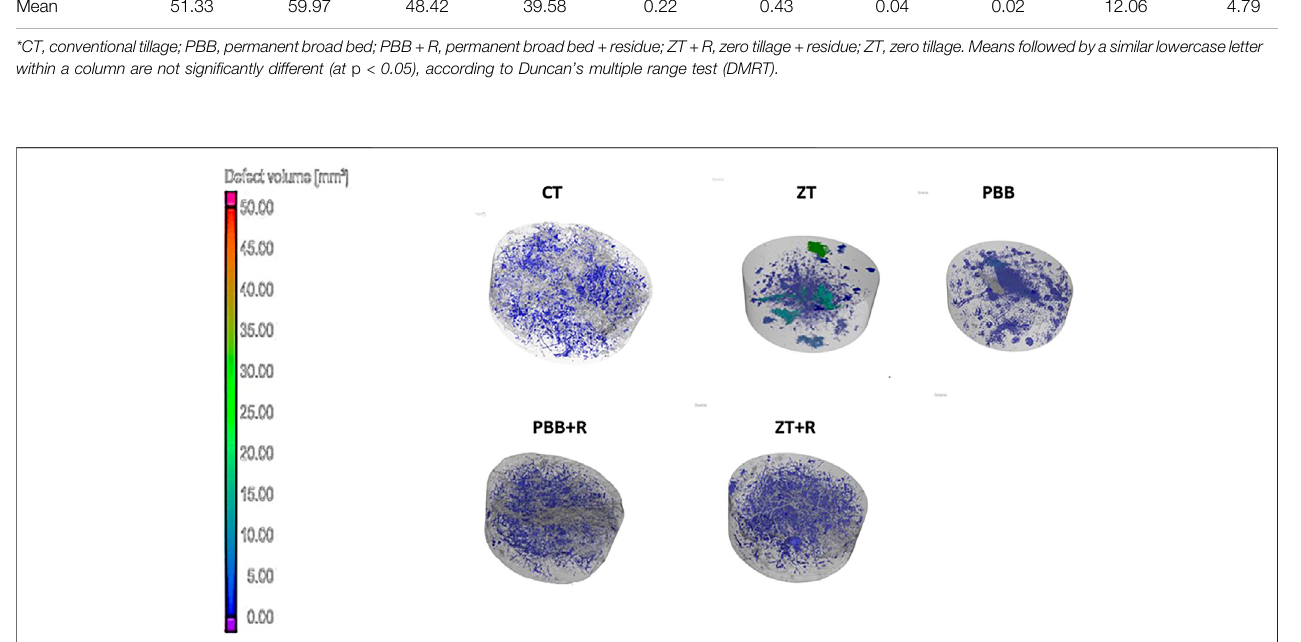
Frontiers in Environmental Science |